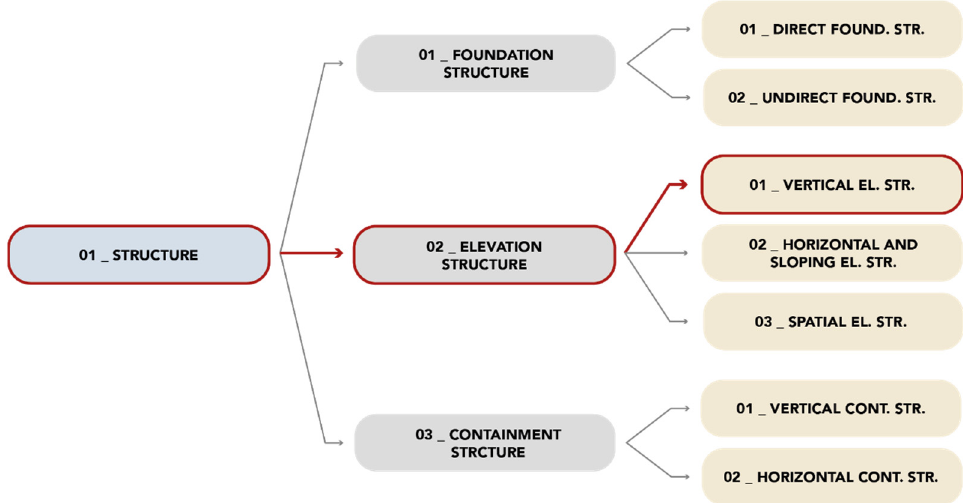
Figure 6. Nomenclature system with the UNI 8290 breakdown structure. In the scheme, the path for the pillar coded name is highlighted.